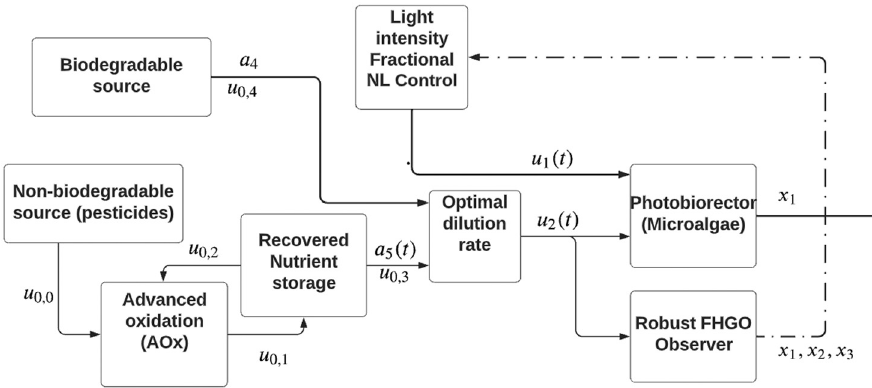
Figure 1: Schematic diagram of the process and the problem to